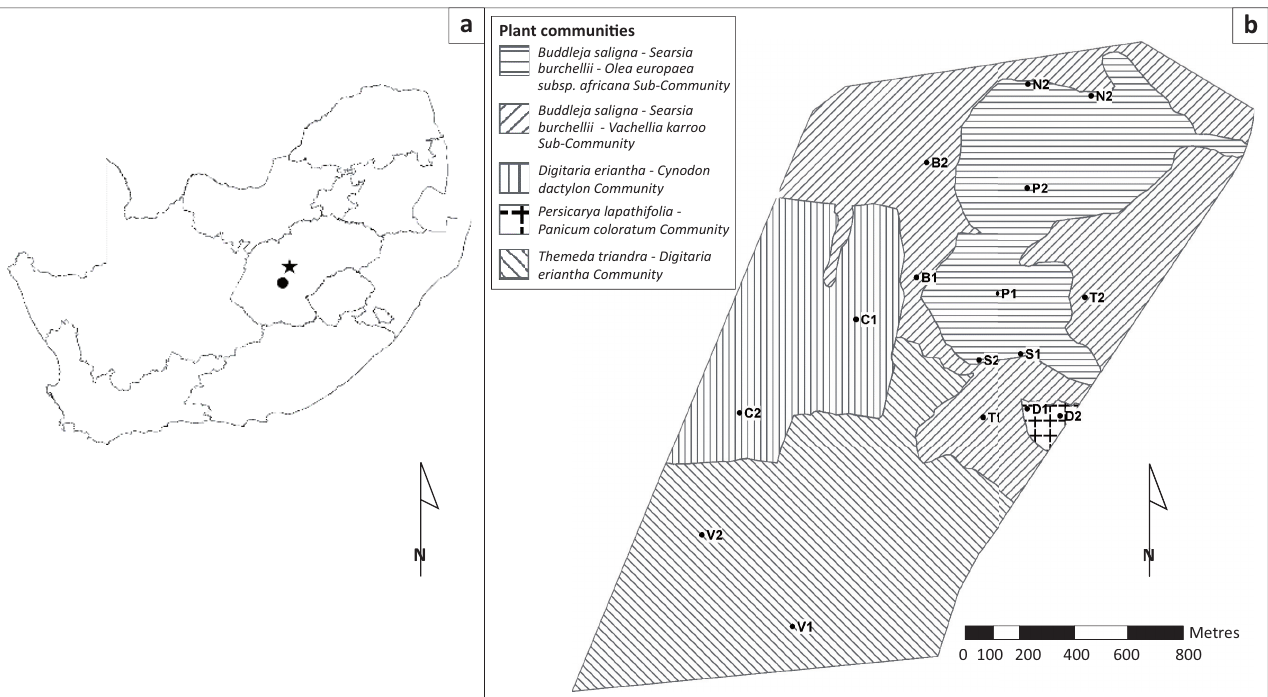
FIGURE 1: (a) Location of the Amanzi Private Game Reserve, Brandfort district, South Africa (star), north-east of Bloemfontein (circle) and (b) vegetation map of the western section of the Amanzi Private Game